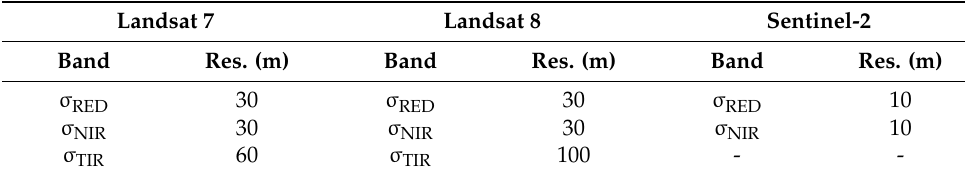
Table 2. Spatial resolution of remote sensing